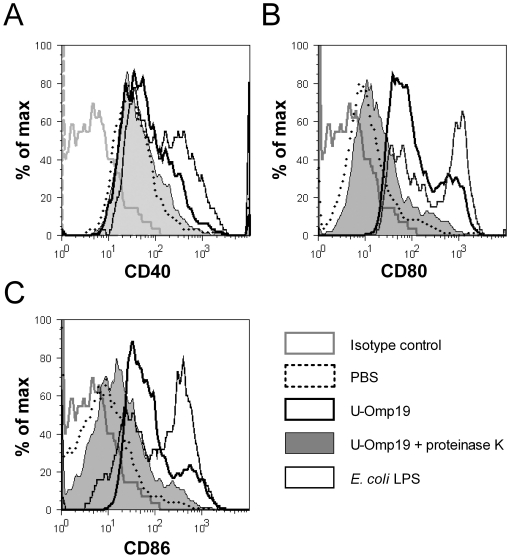

In vivo activation of DCs after U-Omp19 injection.U-Omp19 either untreated or digested with proteinase K, E. coli LPS or PBS alone was injected i.v. to BALB/c mice. Splenic CD11c+ DCs were analyzed for their activation status 20 h after injection by assessing the surface expression of (A) CD40, (B) CD80 and (C) CD86 molecules by flow cytometry. This experiment was conducted three times with similar results. Histograms display results from one representative experiment.